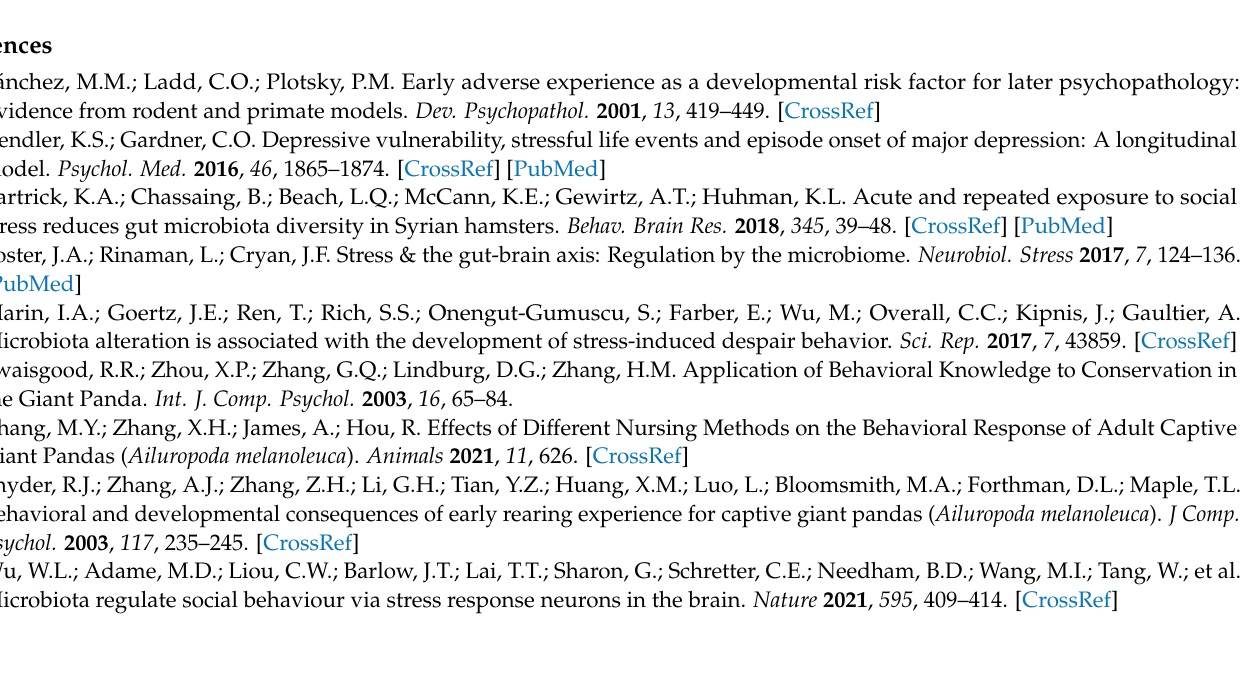
data; Figure S2. Intergroup difference analysis of LC-MS/MS data; Table S1: Species Alpha Diversity Index; Table S2. α diversity index of gut microbes in captive giant pandas adopting different nursing